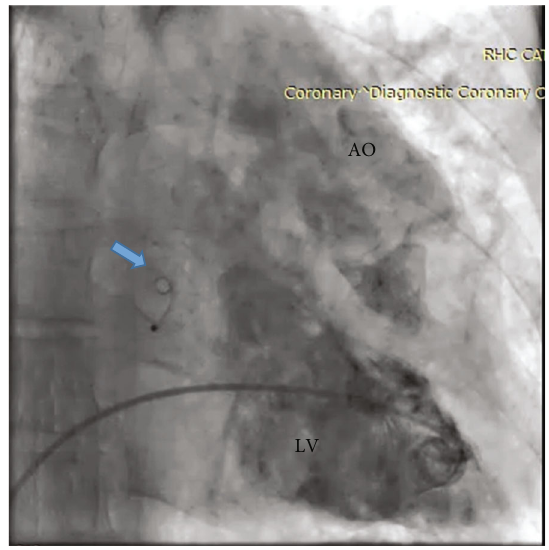
Figure 2: RV injection shows rudimentary systemic RV at the left side and large VSD.